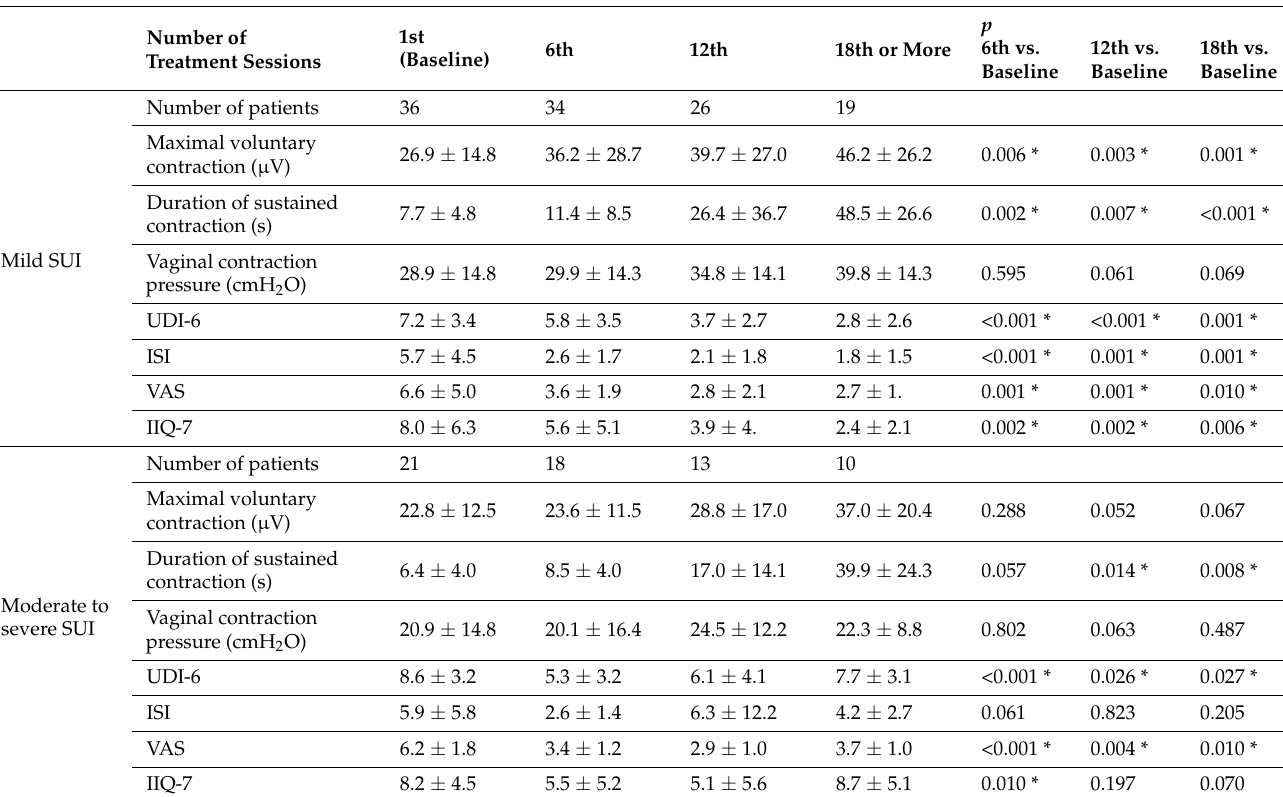
Table 2. Comparisons of electromyography measurements and quality of life before and after treatment between